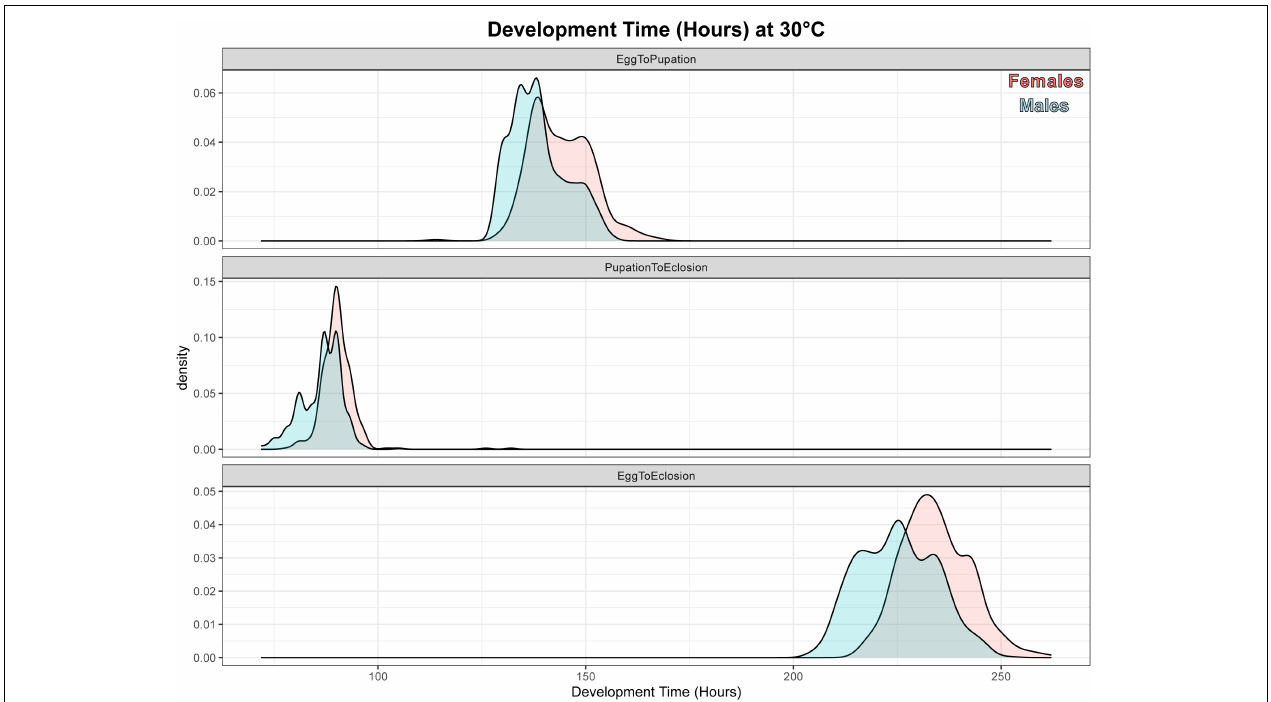
FIGURE 2 | Density plot of sexual dimorphism in development rate for C. rufifacies at 30 ◦ C. These are density plots of hours elapsed ( x -axis) for male (blue) and female (red) C. rufifacies reared at 30 ◦ C, 12:12 LD for time elapsed from egg to pupariation (top panel) , pupariation to eclosion (middle panel) , and egg to eclosion (bottom panel)